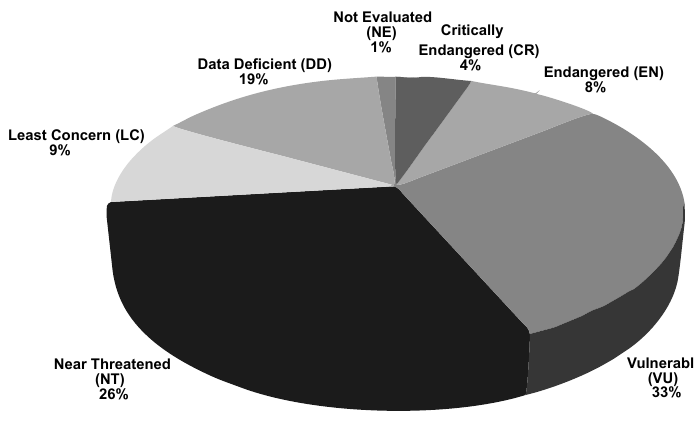
Fig. 8. Conservation status of chondrichthyans from waters around the Andaman and Nicobar Islands,